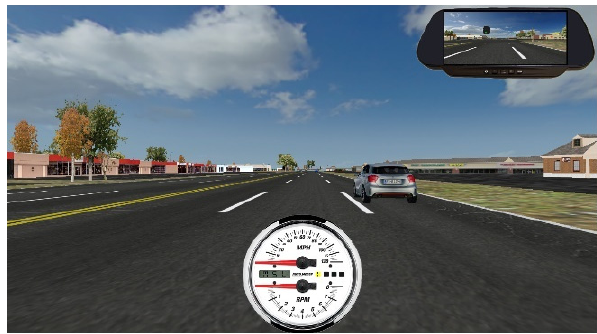
Figure 8. Residential driving scenario.